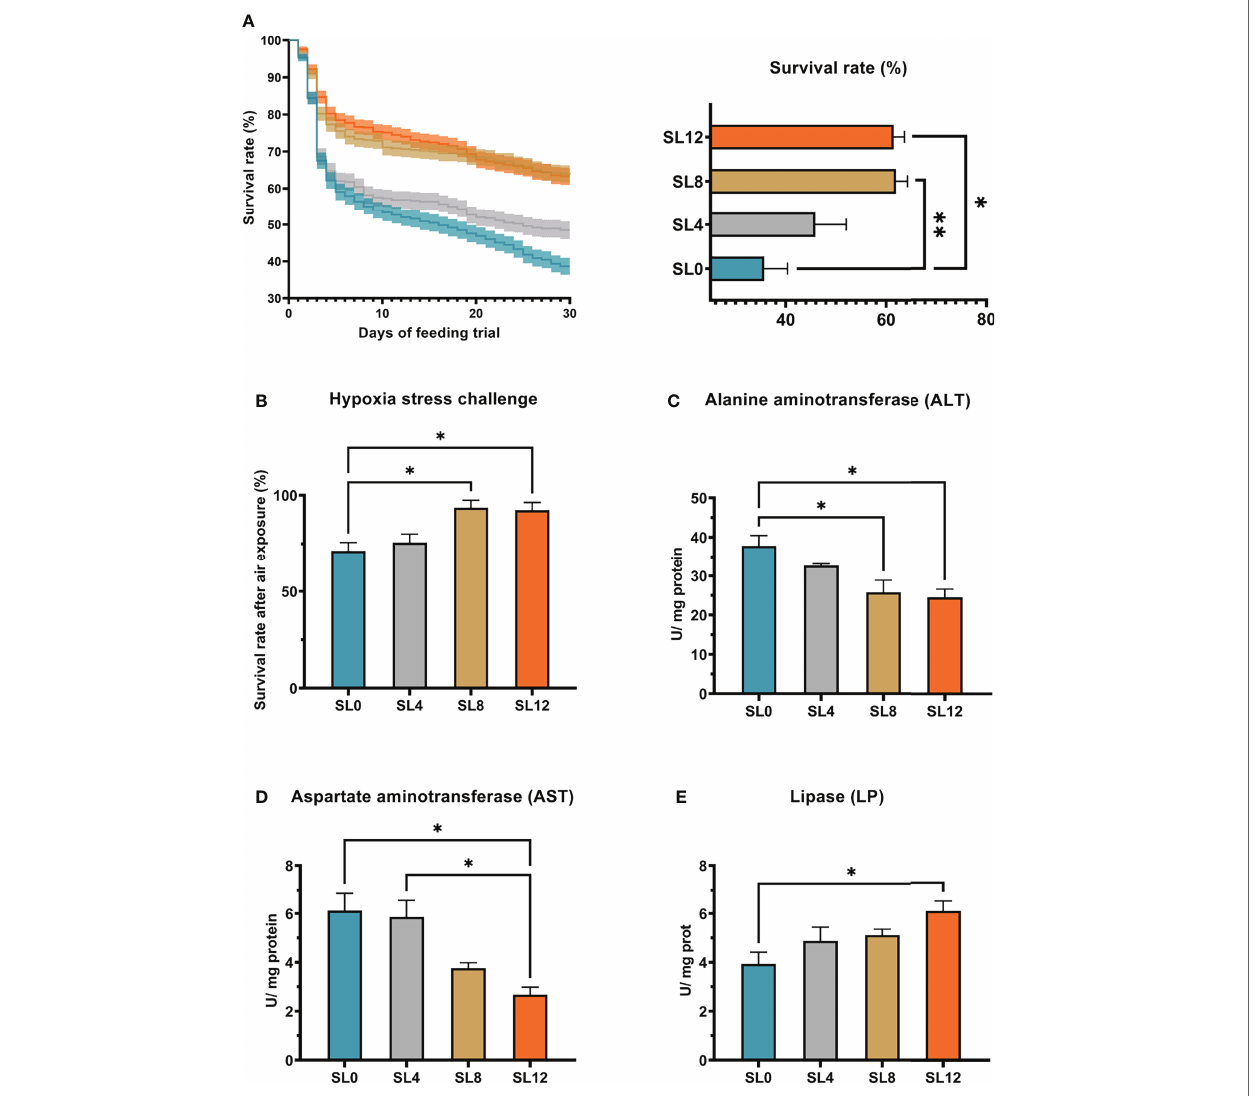
FIGURE 1 | Rock bream larval survival rate, stress resistance to hypoxia stress, and liver tissue metabolism-related enzyme activities. (A) The rock bream larval survival rate was recorded during the feeding trial daily, and final statistical analyses are presented in the right panel. (B) Larval stress resistance to air exposure for 5 minutes. (C-E) Larval liver tissue alanine aminotransferase (ALT) Aspartate aminotransferase (AST) and lipase (LP) enzyme activities correspond to dietary soybean lection inclusion levels. *P < 0.05, **P < 0.01, otherwise, no significant difference (P >